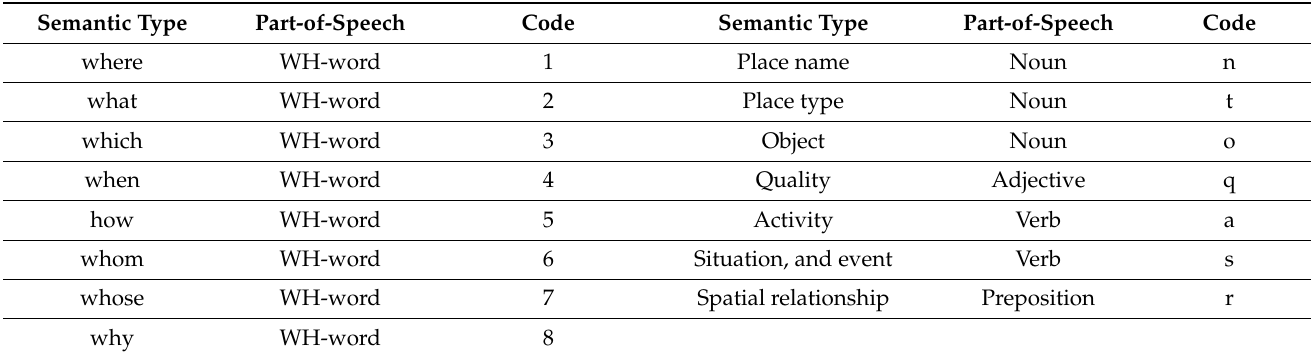
Table 1. Semantic representation encoding from [4]. Examples of each encoding are as